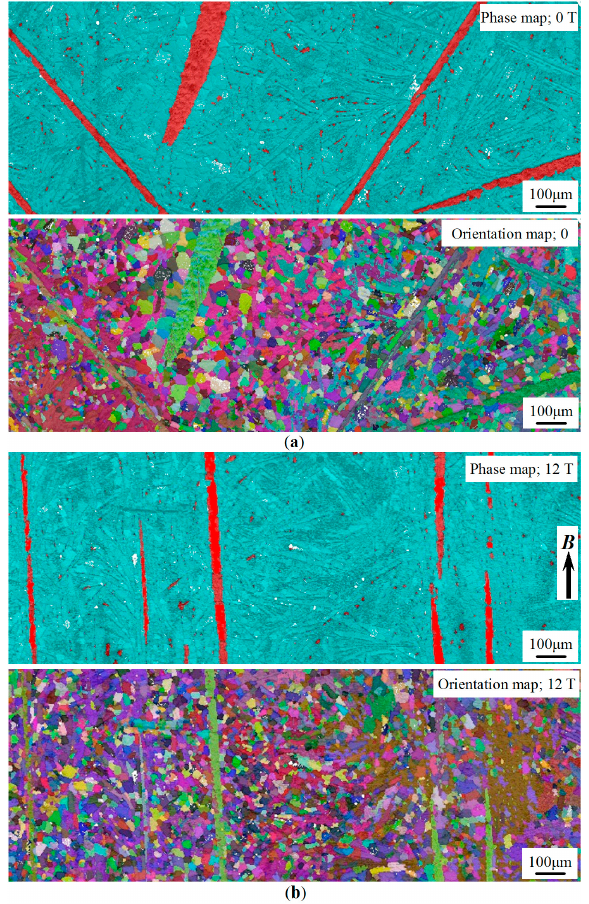
Figure 8. Phase maps and all-Euler orientation micrographs corresponding to the longitudinal structures ( a ) without and ( b ) with a 12 T HMF, respectively. The arrow indicates the direction of B .